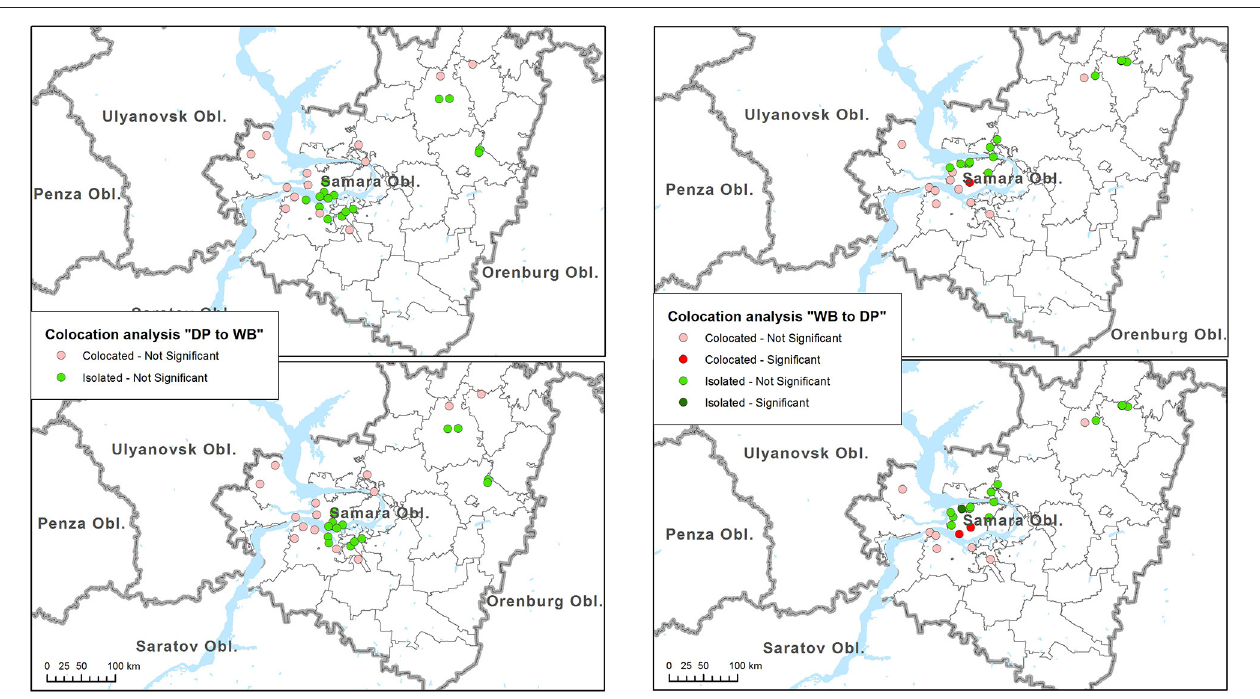
FIGURE 3 | Results of the colocation analysis of African swine fever (ASF) cases in wild boar (WB) near outbreaks in domestic pigs (DP) (left). Colocation of outbreaks in DP near cases in WB (right). Top maps indicate the results for the analysis time span of 14 days, while bottom maps indicated the results for 45-days’ time span.